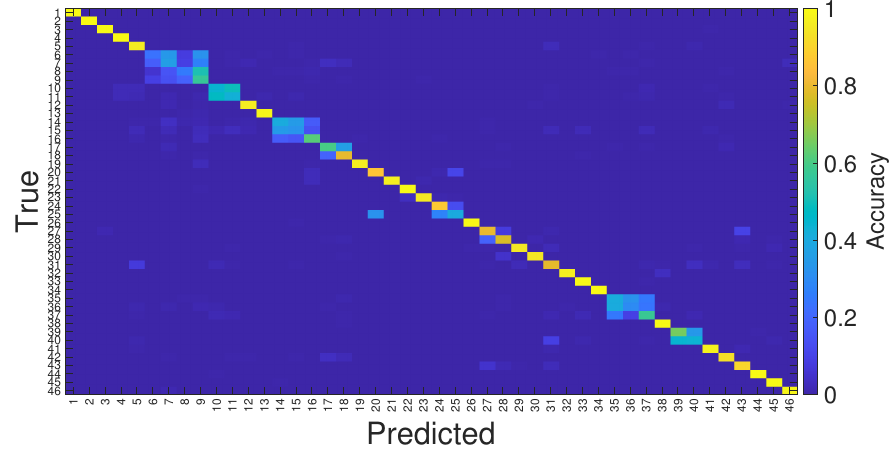
Figure 12. Confusion matrix with FFT at SNR = 30